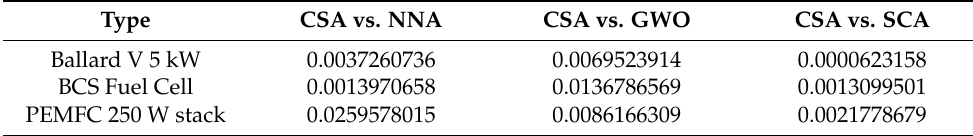
Table 5. The p -values of the t-test of the CSA versus other algorithms.